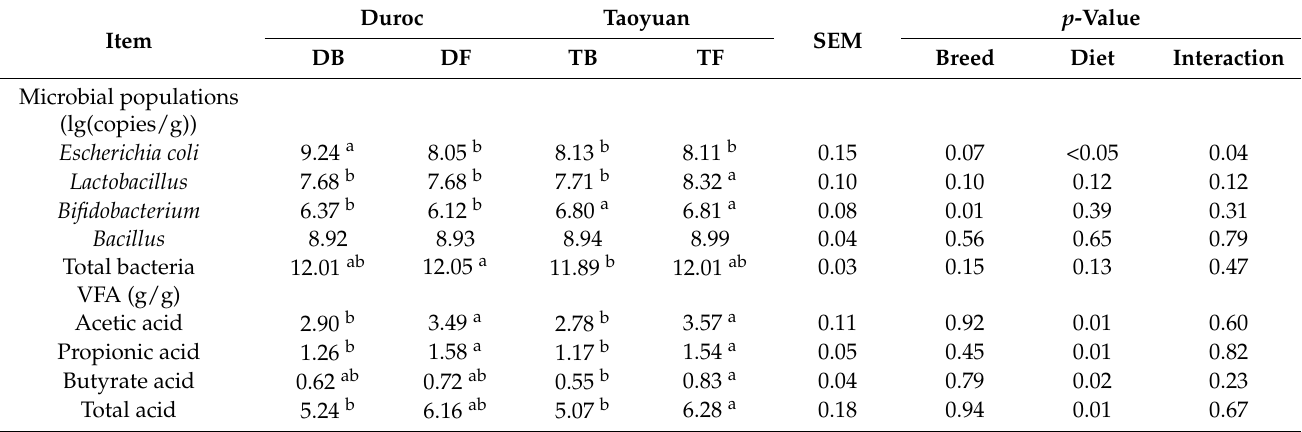
Table 6. Effect of DF on colon microbiota and microbial metabolites in different pig